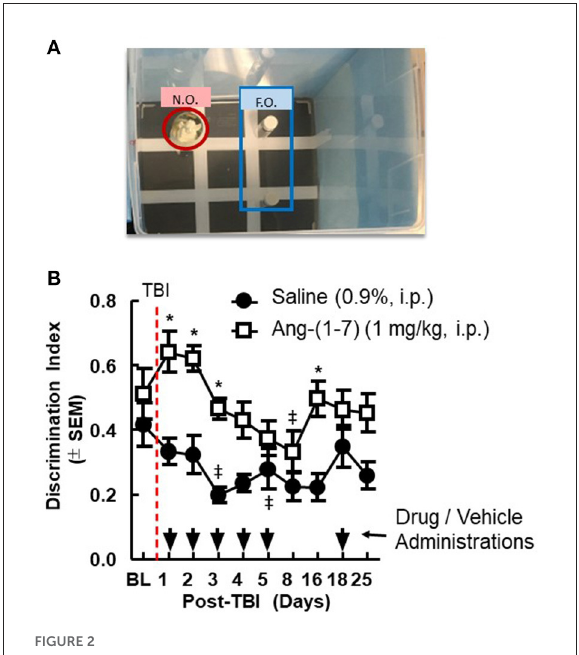
FIGURE2 Cognitive deficits after closed-skull TBI are mitigated by Ang-(1-7). (A) Diagram of Novel Object Recognition set up. (B) Discrimination Ratio as a function of time demonstrates relative maintenance of cognitive function in mice treated with Ang-(1-7) as opposed to normal saline alone. Time of TBI infliction is denoted by the vertical dashed line. Primary administration of either drug or saline vehicle took place 2h post-TBI. All subsequent drug and saline injections took place 30min prior to NOR assays conducted on days 2–16. repeated measures ANOVA (with Tukey correction) was employed to analyze main effect of the drug intervention on DR, followed by Tukey Range test where appropriate. Twenty-four male mice 12 mice in each group, statistically significant ( * p < 0.05) difference between treatment groups; Statistically significant ( ‡ p < 0.05) difference from baseline within the